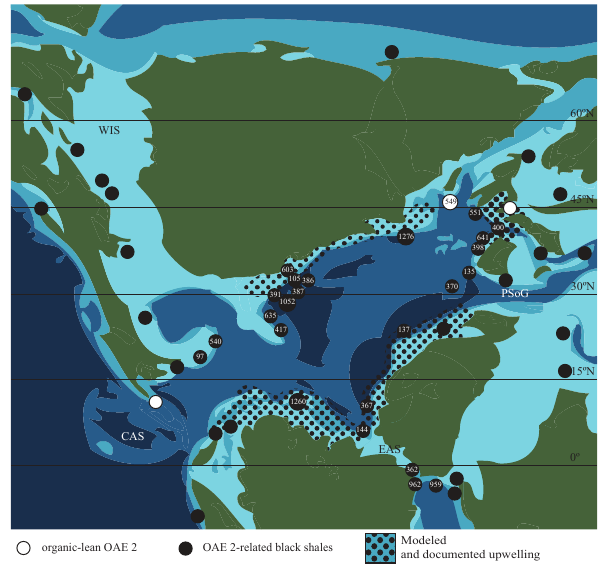
Fig. 12. High total organic carbon map. All localities with the high- est total organic carbon (TOC) values are located in the modelled upwelling zones along the Gondwanan coasts where our model pre- dicts the strongest upwelling of Pacific water. Numbers indicate DSDP/ODP